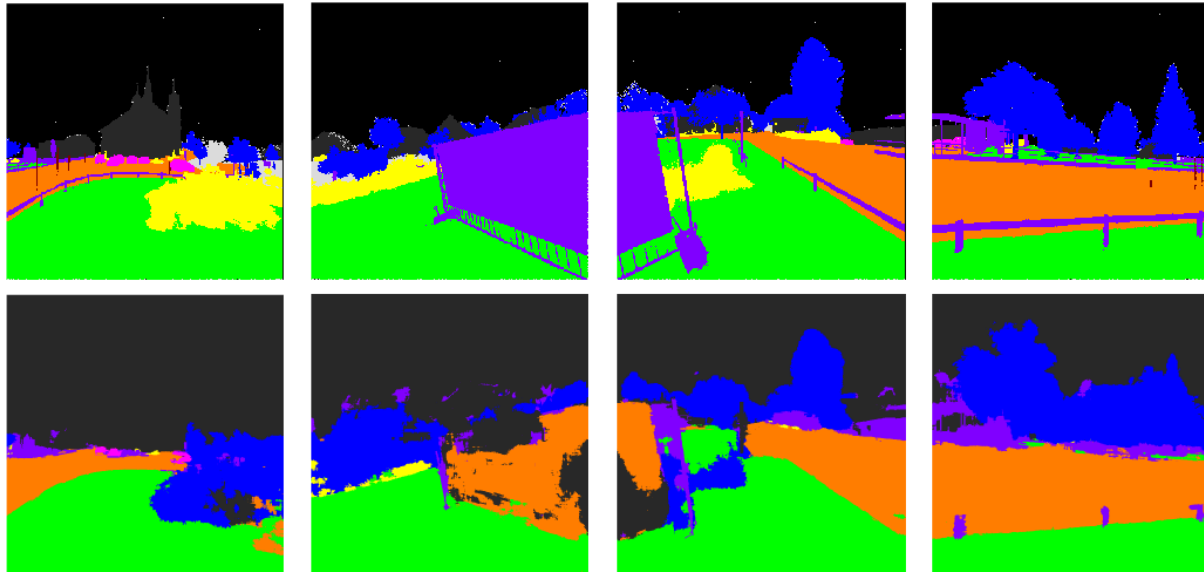
Figure 2: Top row: projection of ground truth to images. Bottom row: results of classification with the image baseline. White: unlabeled pixels, black: pixels with no corresponding 3D point, gray: buildings, orange: man made ground, green: natural ground, yellow: low vegetation, blue: high vegetation, purple: hard scape, pink: